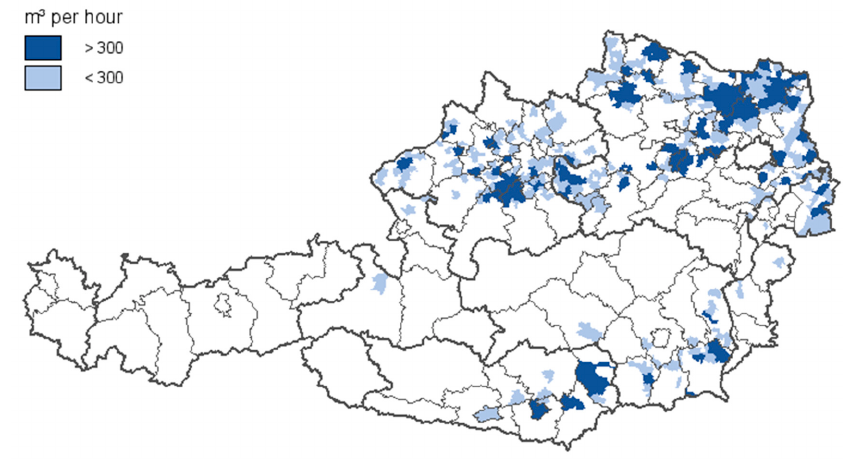
Figure 2. Regional distribution of the possible biomethane injection potential (own analysis).